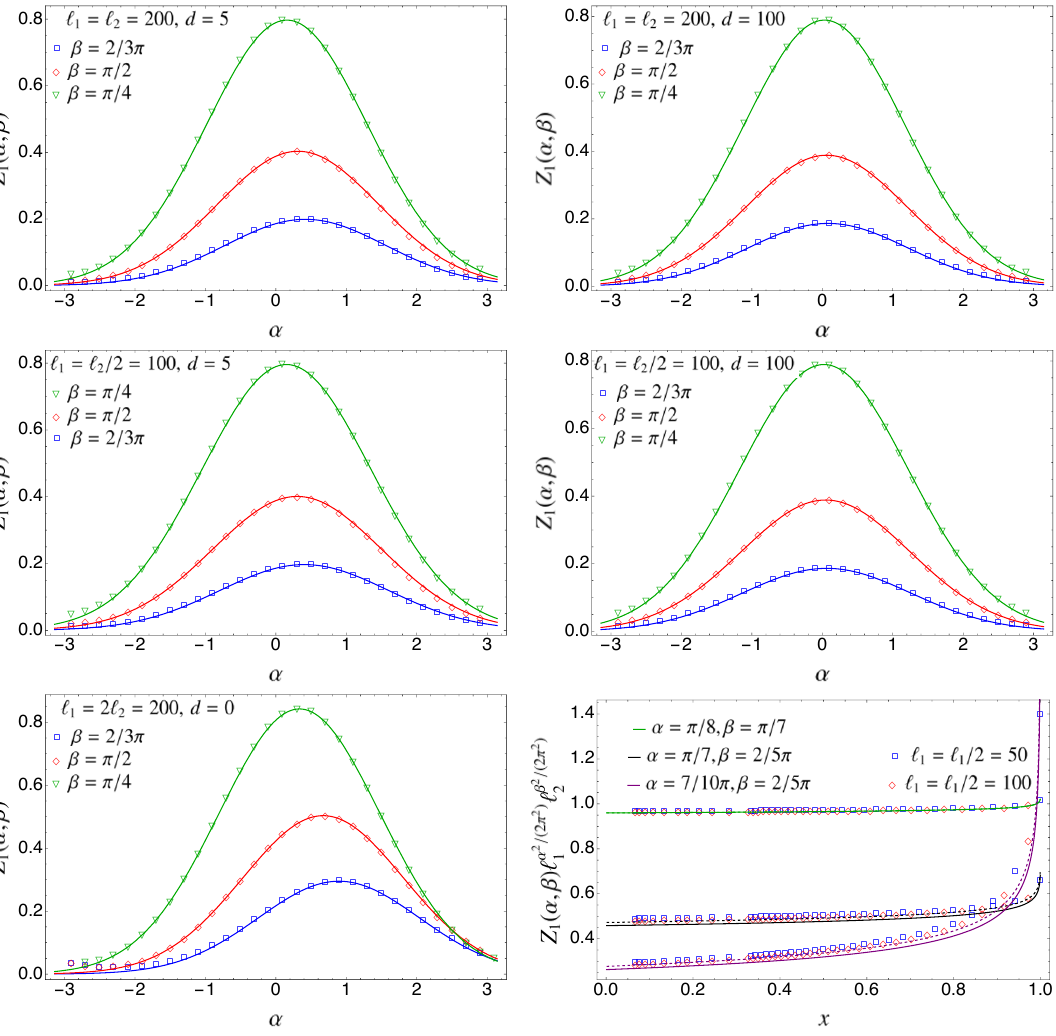
Figure 2 . Analysis of Z A 1 : A 2 ( α, β ) for the tight-binding model. In the top and middle panels, we 1 show Z A 1 : A 2 ( α, β ) as a function of α at fixed β for different intervals of lengths ‘ 1 , ‘ 2 , separated by 1 a distance d > 0 . In this case, the solid lines are the theoretical predictions of eq. (3.16), taking eq. (3.20) for c n ; α,β . In the bottom left panel, we repeat the analysis but considering adjacent inter- vals ( d = 0 ) and the solid curves correspond to eq. (3.18), with ˜ c n ; α,β conjectured in eq. (3.24). In the bottom right panel, we plot Z A 1 : A 2 ( α, β ) as a function of the cross-ratio x . Here the solid lines corre- 1 spond to eq. (3.16) using the exact expression for c n ; α,β of eq. (3.20), while for the dashed curves we have considered instead the quadratic approximation for this constant of eq. (3.22). In all the cases, the points are the exact numerical values for Z A 1 : A 2 ( α, β ) calculated as described in appendix 1